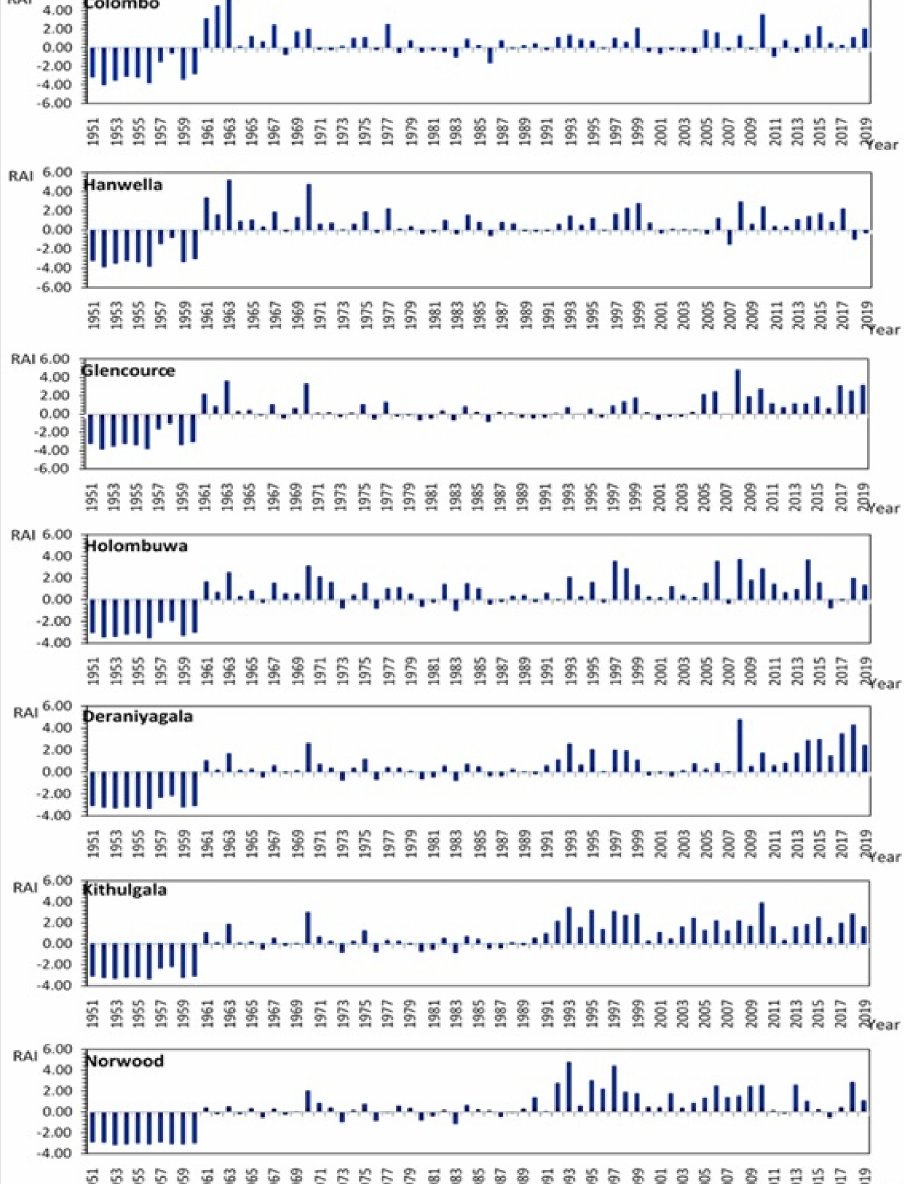
Figure 4. Annual variability of RAI from 1951 to 2019 at the seven selected stations in the study area. As in Figure 4, generally, the first ten years of the study period were dry and after 1961, the RAI fluctuated until 1990. The last 20-year period was prominent as a humid period. However, spatial variability can be recognized. Spatial changes in rainfall patterns in the study area began in 1990, and many changes have appeared in the lower river basin. The spatial variability of the RAI for the selected years is shown in Figure 5. The annual RAI fluctuated at the Colombo station, and the number of wet years is lower than at other stations. Hanwella, Glencourse, and Deraniyagala (middle part of the river basin) appear with a similar pattern of RAI distribution, and Holombuwa, Kithulgala, and Norwood (upper part of the river basin) appear with different temporal patterns of RAI over the